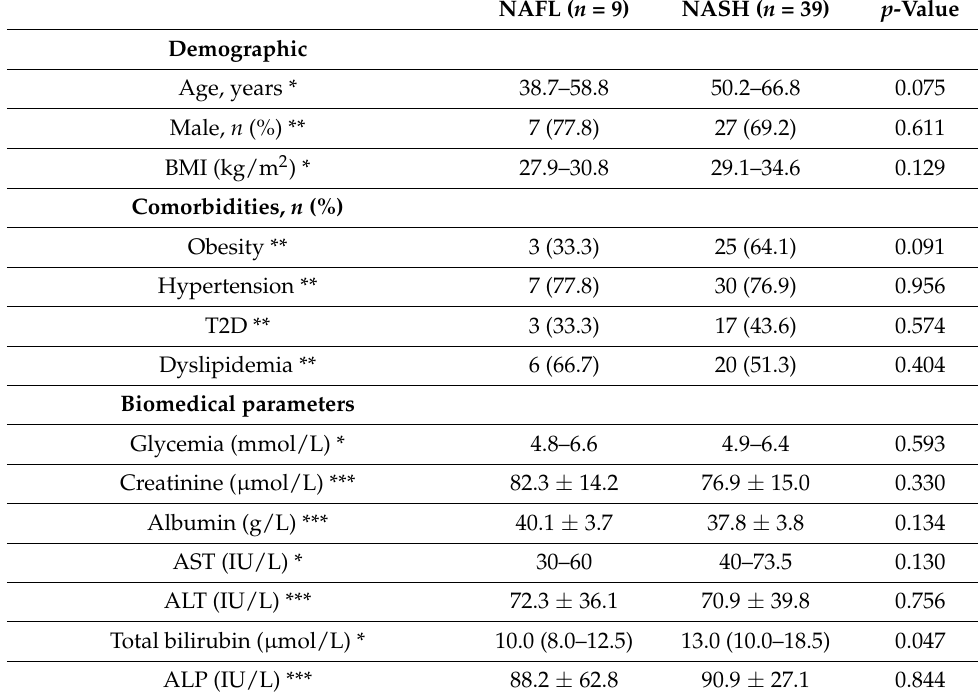
Table 1. Baseline information of study population. The bold value indicates all the significant p -values <